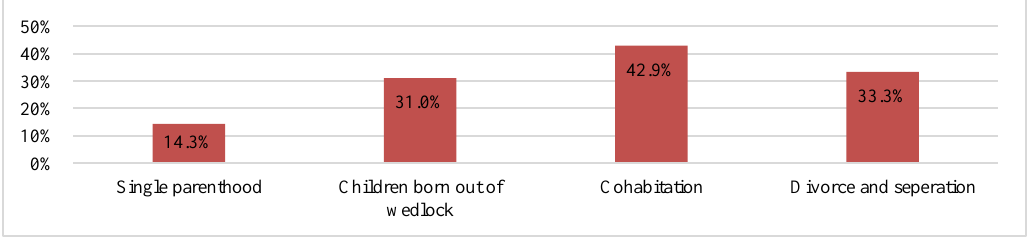
Figure 4: Policies on Family and Marriage that Discriminate Youths; Source: Field Data